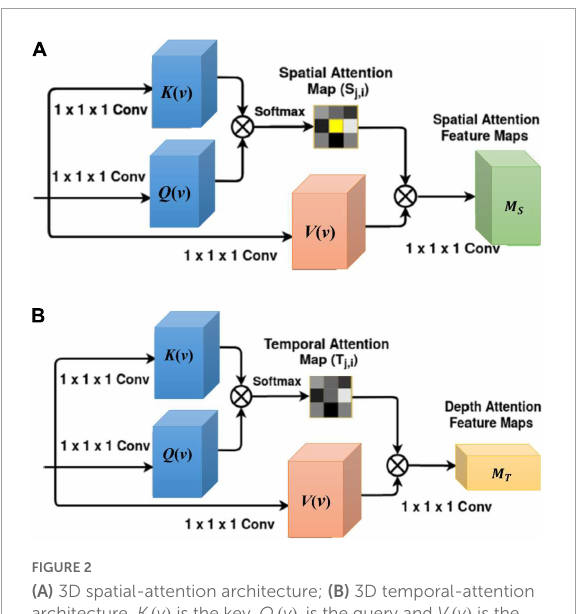
FIGURE2 (A) 3D spatial-attention architecture; (B) 3D temporal-attention architecture. K ( v ) is the key, Q ( v ) is the query and V ( v ) is the value. N is defined as an element-wise multiplication operation. Noted that spatial or depth is an interchangeable